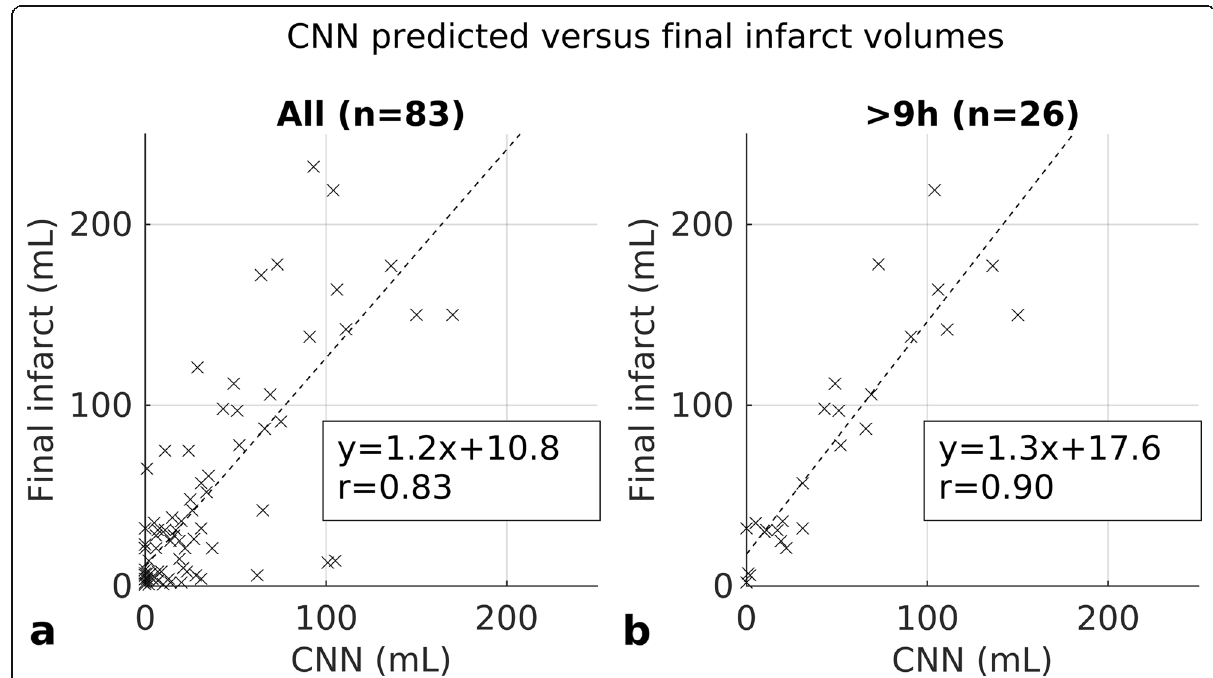
Fig. 4 Infarct lesion volume correlation between convolutional neural network (CNN) predictions based on acute phase computed tomography angiography (CTA) and final infarct volumes. All patients ( a ). Patients imaged more than 9 h after symptom onset ( b )